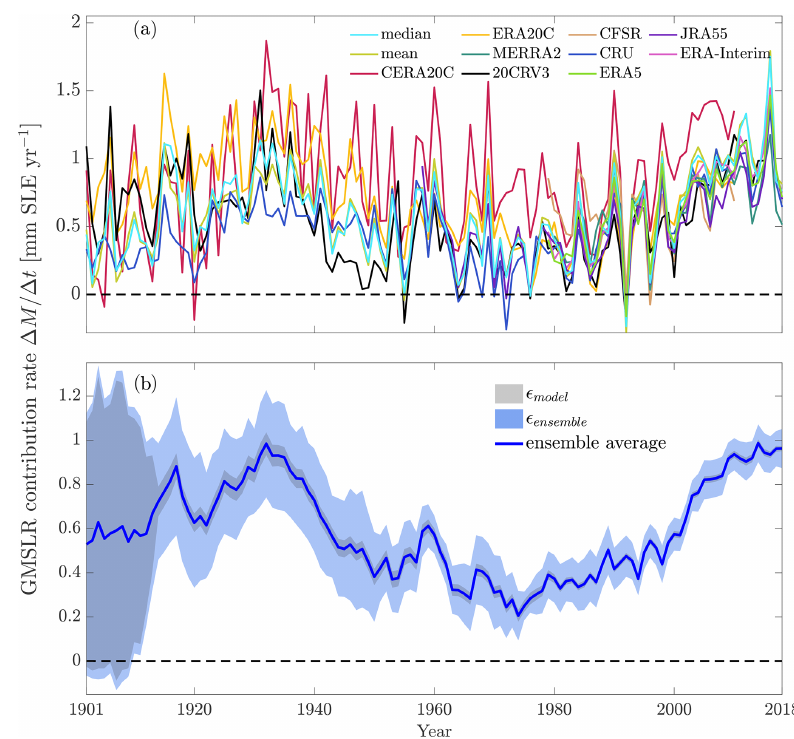
Figure 7. (a) Annual glacier mass change rates expressed in GMSLR contribution rate for all forcing data sets. (b) Mean of ensemble output mass change rates. A 5-year moving average is shown for clarity. Shaded areas are the mean model uncertainty (grey, (cid:15) model ; see Eq. 10) and total ensemble uncertainty (blue, (cid:15) ensemble ; see Eq. 11), which are shown at the 90% confidence level. Results of the CERA20C forcing are excluded from the ensemble mean (see Sect. 3.1.1). Note the different vertical scales of the panels.